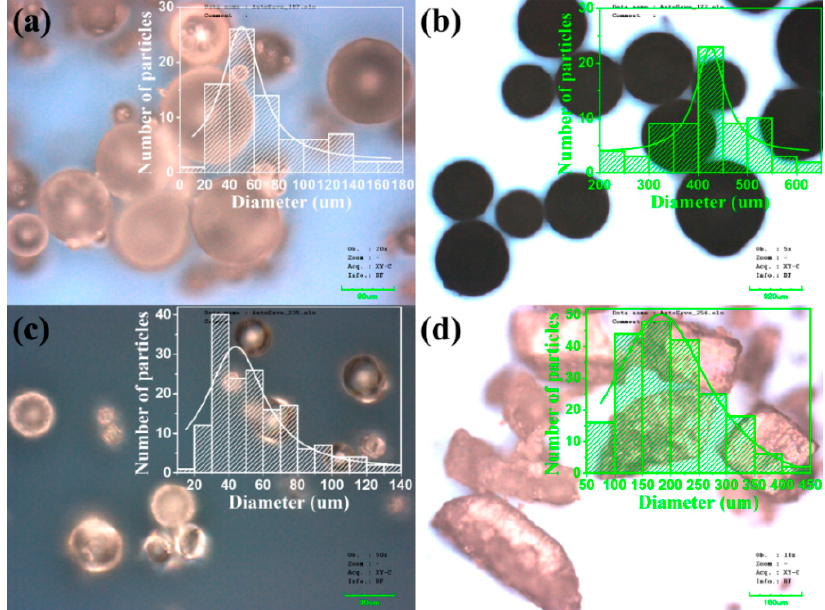
Figure 3. CLSM (Confocal Laser Scanning Microscope) images of ( a ) PE paraffin, ( b ) oleamide, ( c ) polydextrose, ( d ) PEG6000 particles.